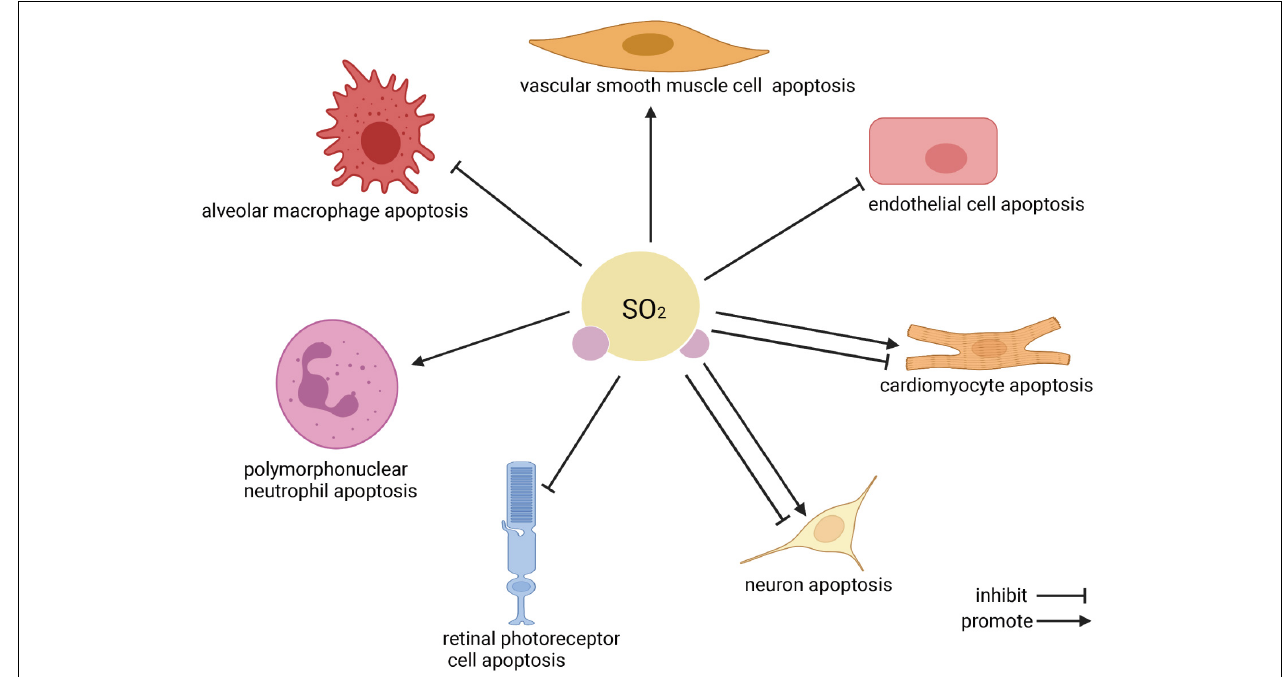
FIGURE 2 | The effect of endogenous SO 2 on cell apoptosis. According to the clockwise direction, the SO 2 target cells are shown beginning from vascular smooth muscle cells. In the cardiovascular system, endogenous SO 2 promotes vascular smooth muscle cell apoptosis, inhibits vascular endothelial cell apoptosis, and inhibits/promotes cardiomyocyte apoptosis. In the nervous system, endogenous SO 2 inhibits/promotes neuron apoptosis, and reduces the apoptosis of retinal photoreceptor cells. Regarding immune cells, SO 2 promotes polymorphonuclear neutrophil apoptosis but inhibits macrophage apoptosis.